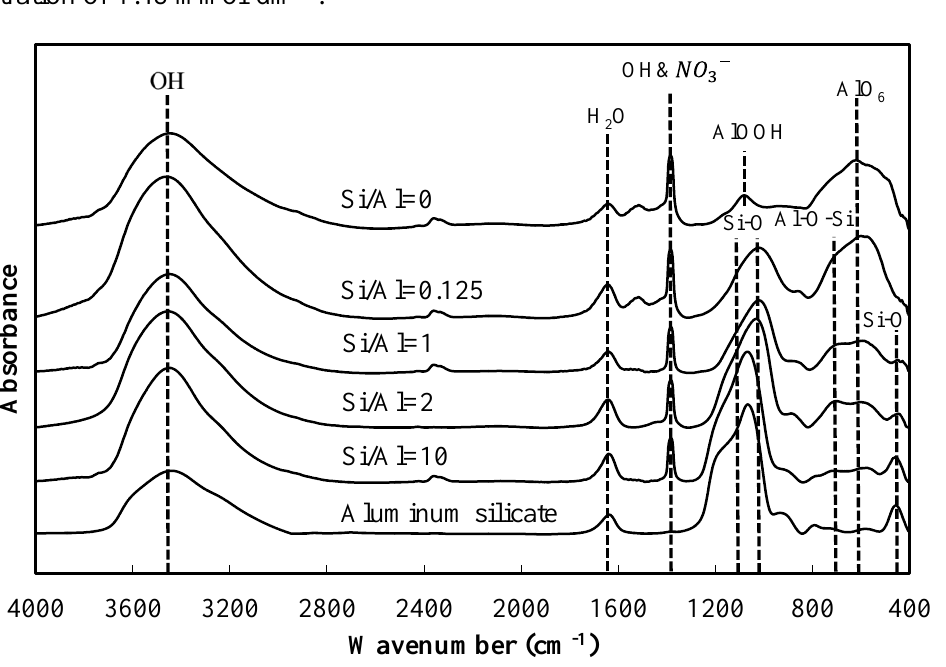
Figure 6. FT-IR spectra of silicate adsorbed residues at pH 9 at an initial aluminum concentration of 1.48 mmol·dm −3 .